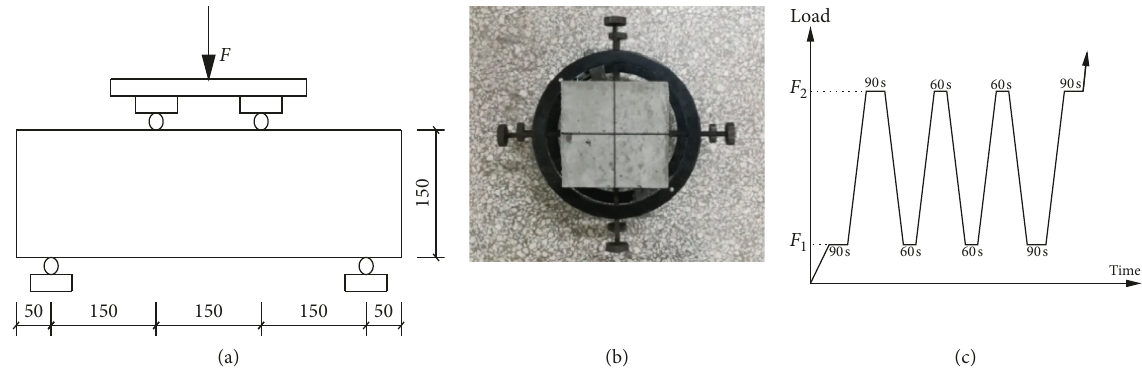
Figure 1: (a) Flexural loading method, (b) elastic modulus device, and (c) elastic modulus loading